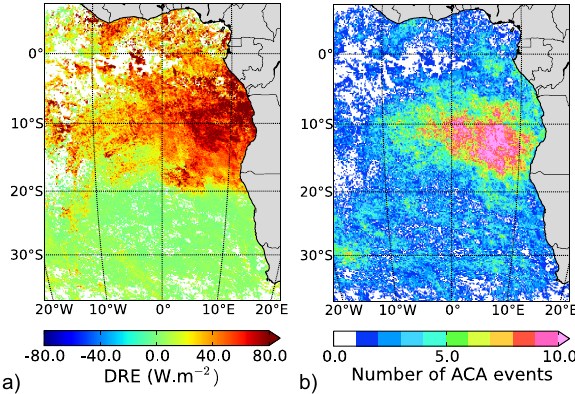
Figure 11. Frequency distribution of the aerosol DRE above clouds for August 2006 for the southeast Atlantic Ocean. Only events with COT ≥ 3 and CF = 1 are